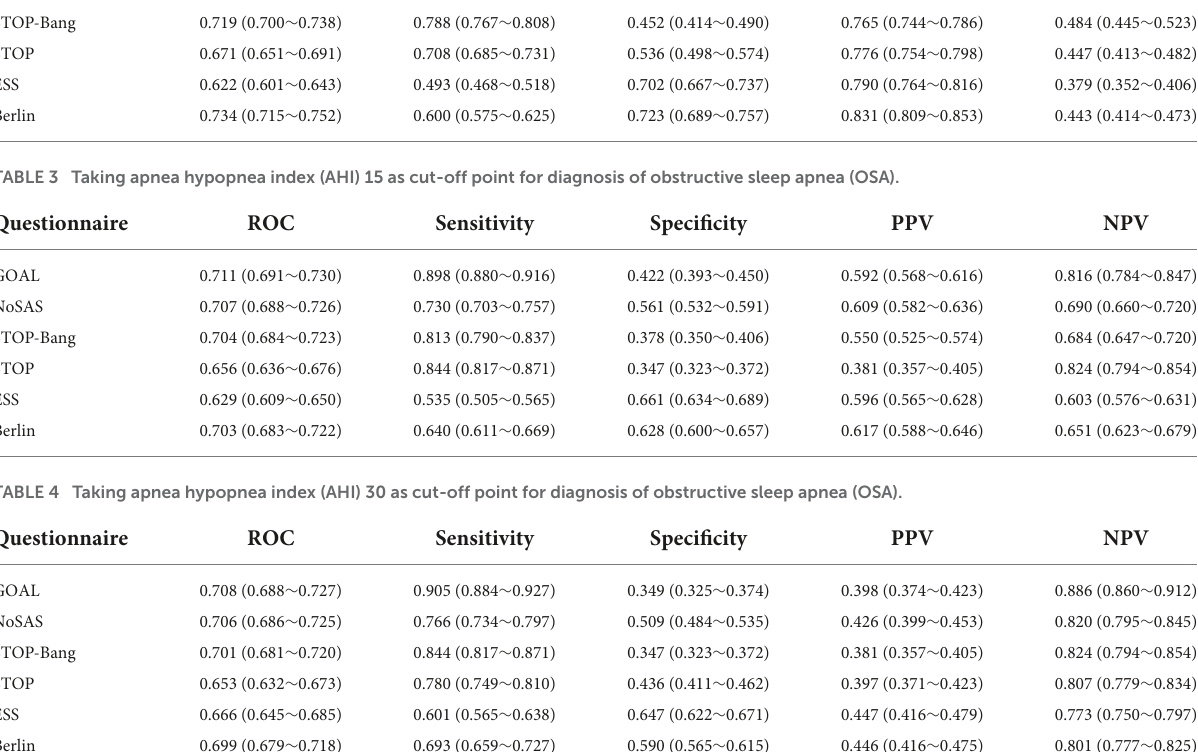
TABLE 2 Taking apnea hypopnea index (AHI) 5 as cut-off point for diagnosis of obstructive sleep apnea (OSA). Questionnaire